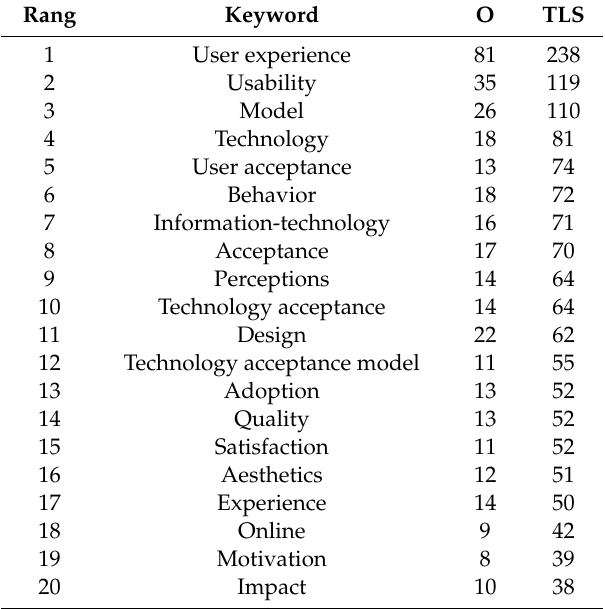
Figure 5. Keyword co-occurrence map. Source: Own elaboration based on VOSViewer. Table 5. Most relevant keywords. Source: Own elaboration based on Table 5. Most relevant keywords. Source: Own elaboration based on VOSviewer.